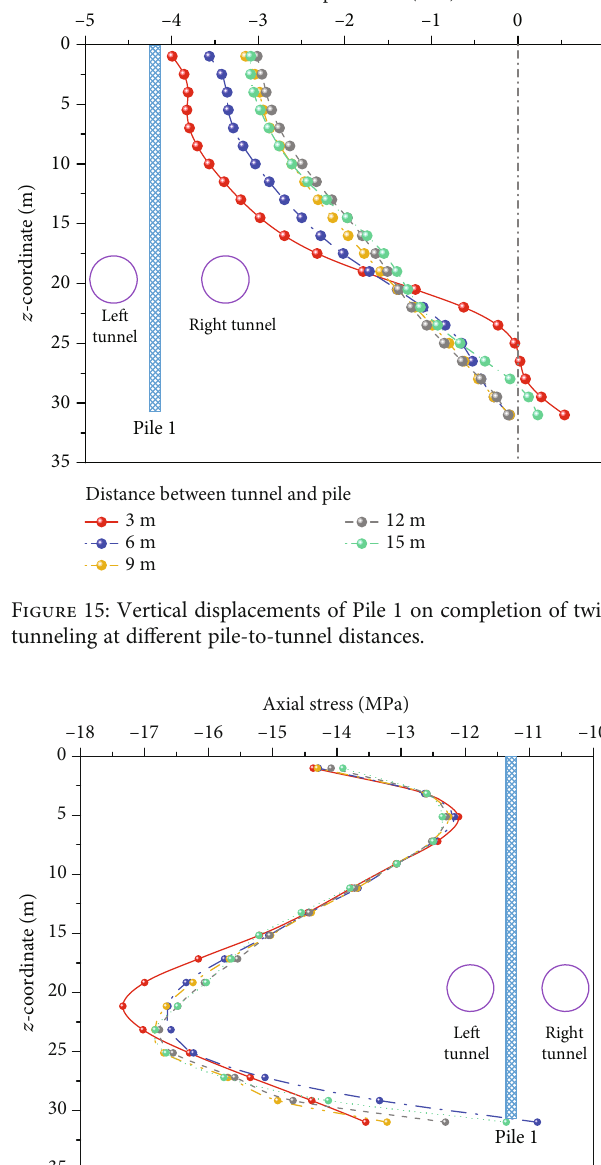
5.2. E ff ect of the Distance between Tunnel Faces. Figure 17 shows the variations of the maximum positive and negative horizontal displacements of Pile 1 on completion of twin tunneling with the distance between tunnel faces. From this fi